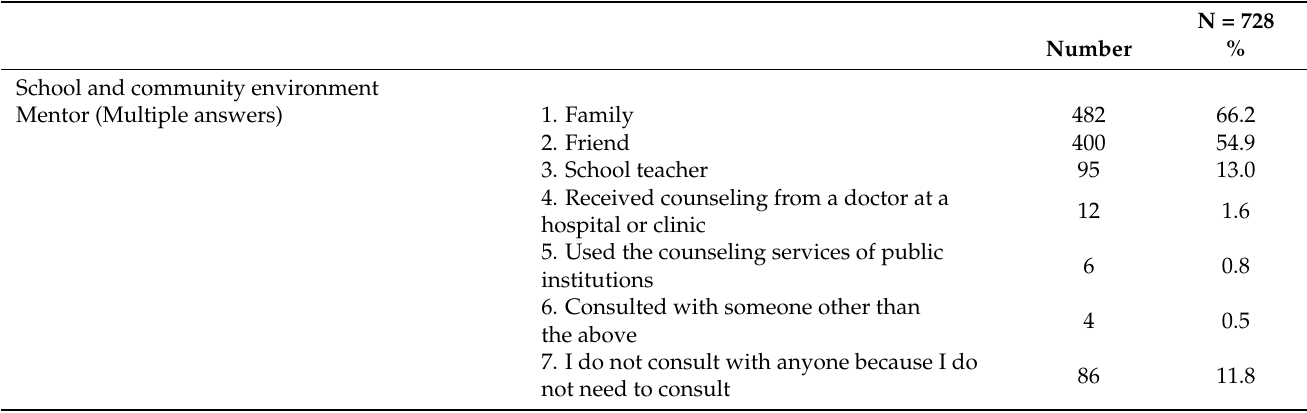
Table 2. Descriptive statistics for school and community environment and mental